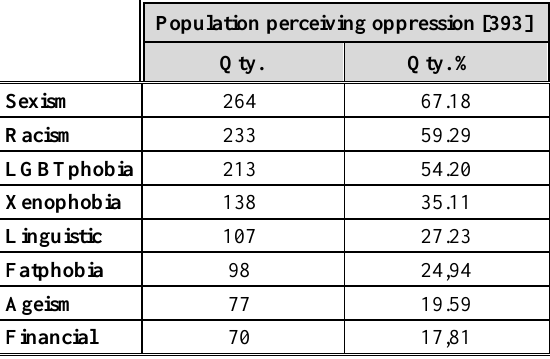
Table 6 : Types of oppression and their occurrence, by oppression Population perceiving oppression [393]